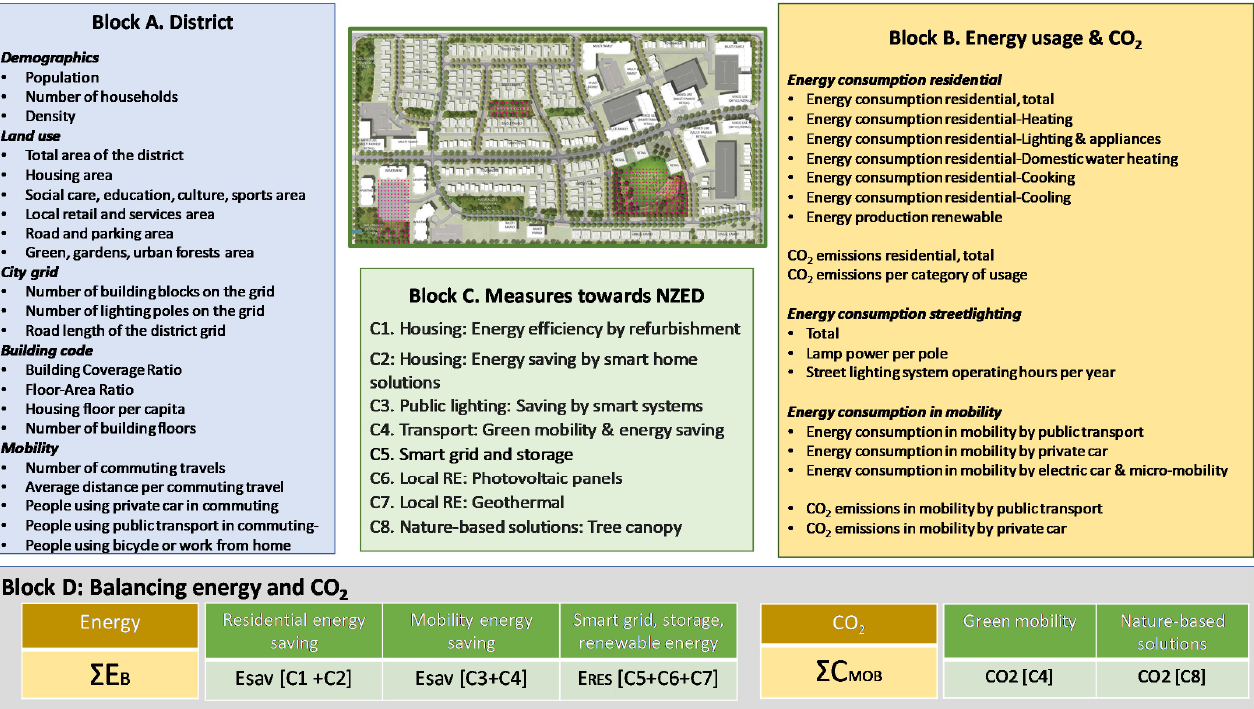
Figure 1. Building blocks of the NZED